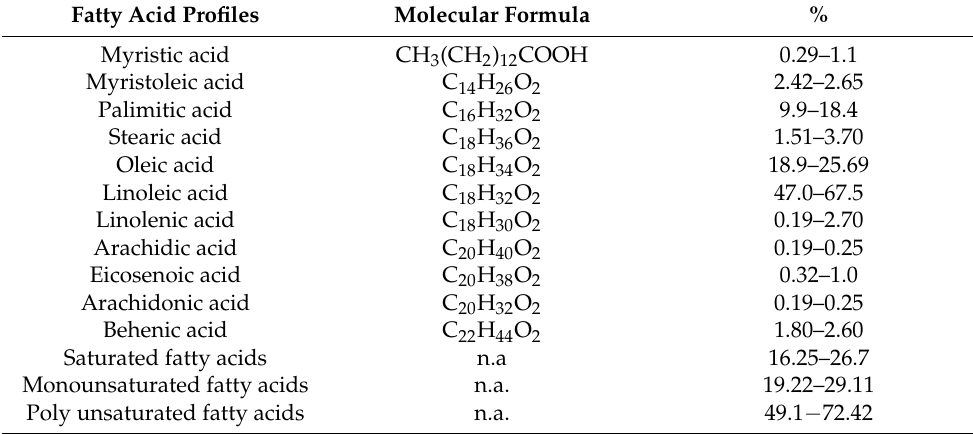
Table 2. Fatty acid profile of N. sativa